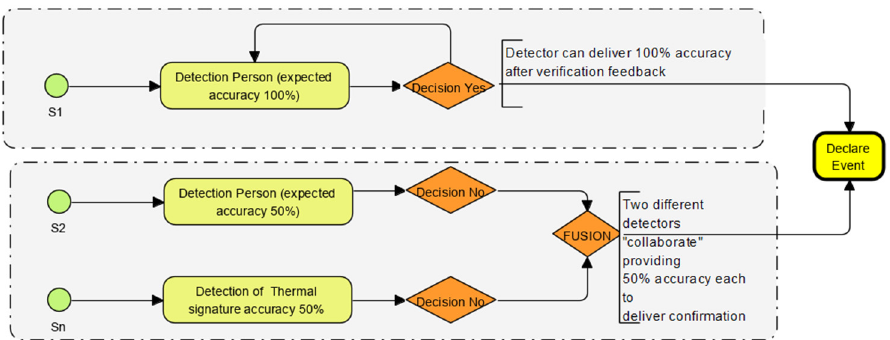
Figure 3. Reinforcing and collateral data workflows demonstrate how data from different sensors “collaborate, corroborate and confirm” outcomes. (Sensors S1 to Sn, Probability & accuracy in yellow, decision points in mauve diamond and outcome from “fusion” in yellow).